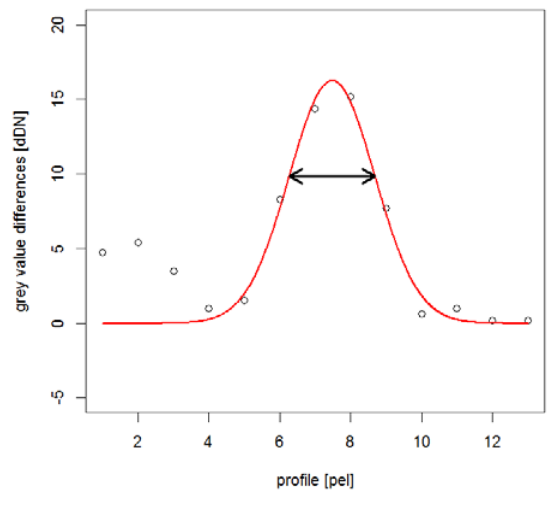
Figure 3. Point Spread Function derived from differences in intensity (grey) values in a profile . The line with two arrows represents